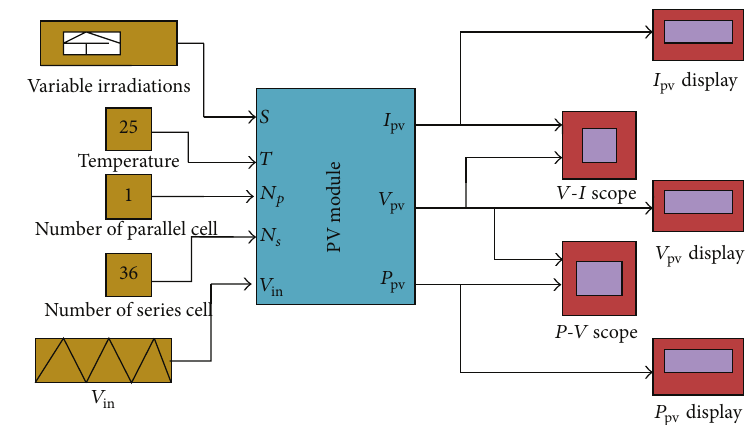
Figure 3: External Simulink window view of the PV